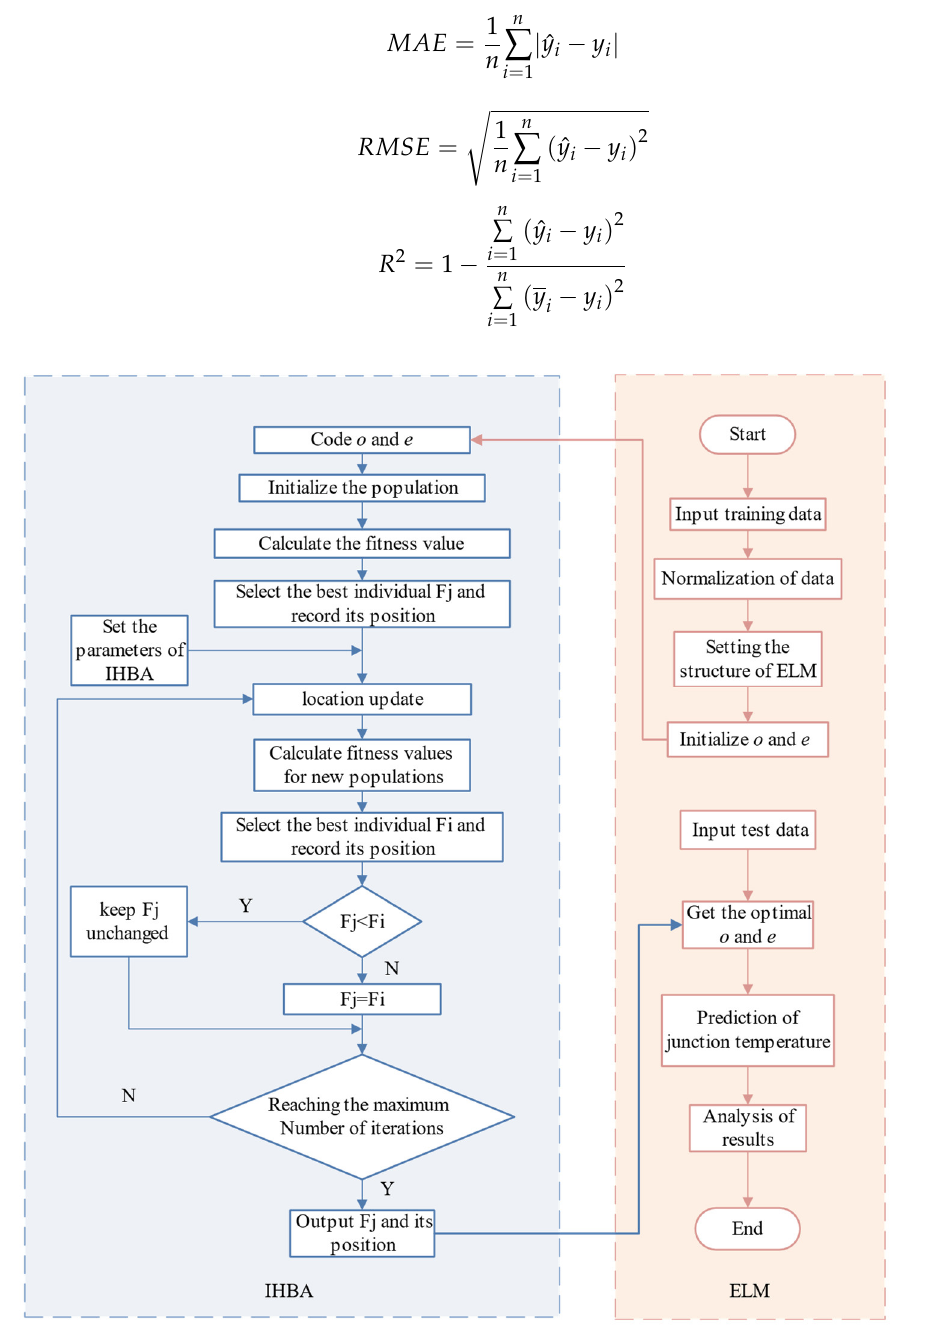
Figure 7. Flow chart of the IHBA-ELM model. Evaluate the efficiency of these models by mean absolute error (MAE), root mean square error (RMSE), and R-square (R 2 ). A smaller MAE indicates that the model has higher accuracy. A smaller RMSE indicates better stability of the model. A smaller differ- ence between R 2 and 1 indicates a better correlation between the input and output.